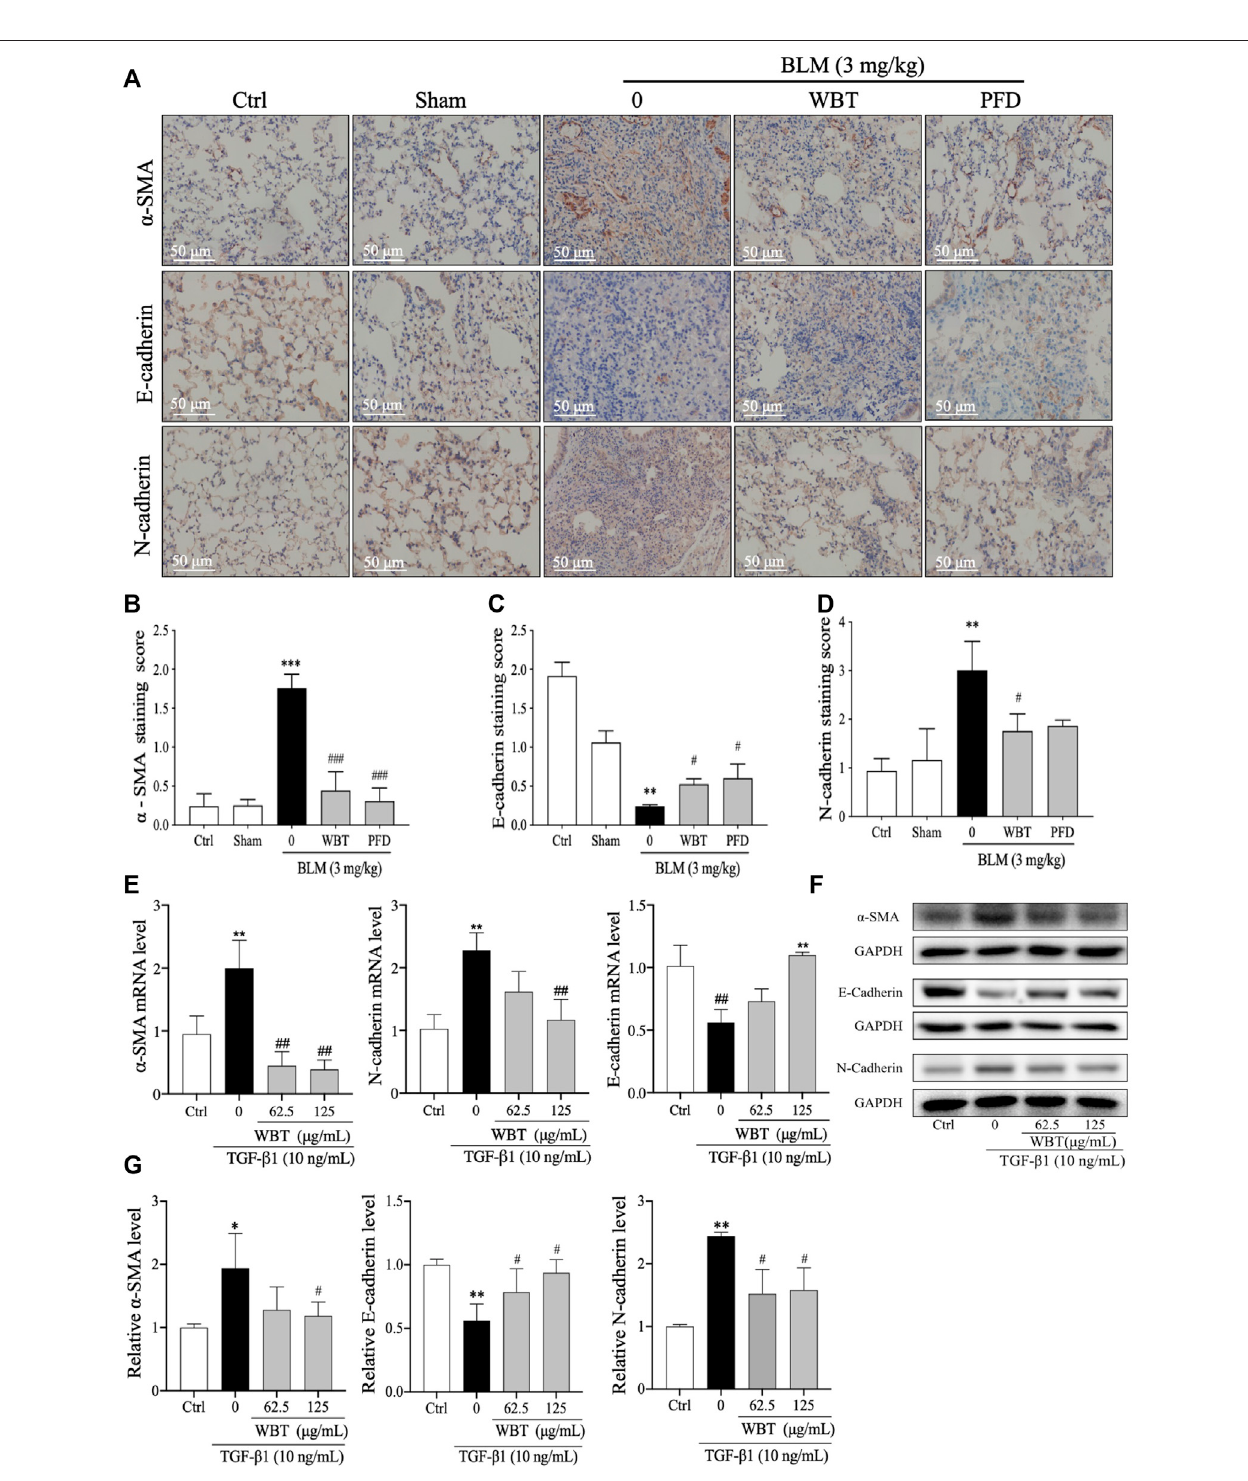
FIGURE 8 | WBT formula inhibited epithelial – mesenchymal transition induced by BLM in the mouse model and TGF- β 1 in the TC-1 cell model. (A) The levels of α - SMA, E-cadherin, and N-cadherin in the lung tissues from control (Ctrl), sham, BLM, and BLM + WBT/PFD groups were determined by immunohistochemical assay. Scalebar (cid:1) 50 μ m. (B,D) Thelevelsof α -SMA,E-cadherin,andN-cadherin from (A) werequanti fi ed(n (cid:1) 5). (E) Afterincubation withTGF- β 1and/or WBTfor48h,qPCR analysis was performed and the relative mRNA levels of α -SMA, E-cadherin, and N-cadherin in TC-1 cells were calculated and normalized to GAPDH. (F,G) The proteinlevelsof α -SMA,E-cadherin,andN-cadherininTC-1cellstreatedwithTGF- β 1and/orWBTfor48 hweredeterminedbyWesternblotanalysis.GAPDHwasused as the loading control. Data are from three independent experiments. * p < 0.05, ** p < 0.01, and *** p < 0.001, compared to the sham group; # p < 0.05, ## p < 0.05, and ### p < 0.001, compared to the BLM or TGF- β 1 group. BLM, bleomycin; WBT, Wenfei Buqi Tongluo formula; PFD, pirfenidone (TGF- β 1, 10 ng/ml).